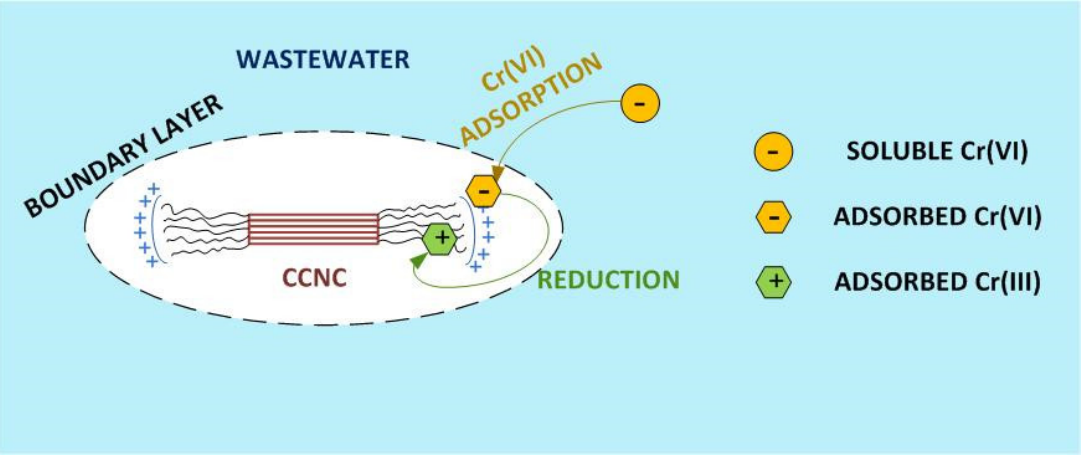
Figure 10. Graphical scheme of the adsorption-reduction mechanism of hexavalent chromium through CCNC.